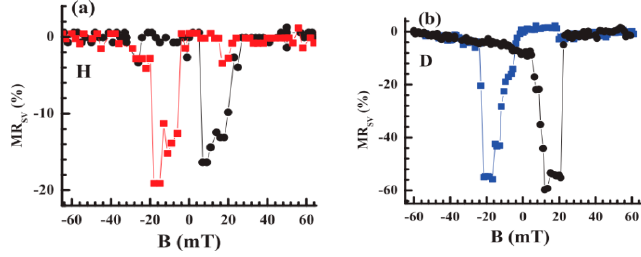
Figure 5. MR curves of two 40 nm thick OSV based on ( a ) H-Alq 3 ( b ) D-Alq 3 , measured at V = 12 mV and T = 10 K. Adapted from [98], with permission from © 2015 American Physical Society.